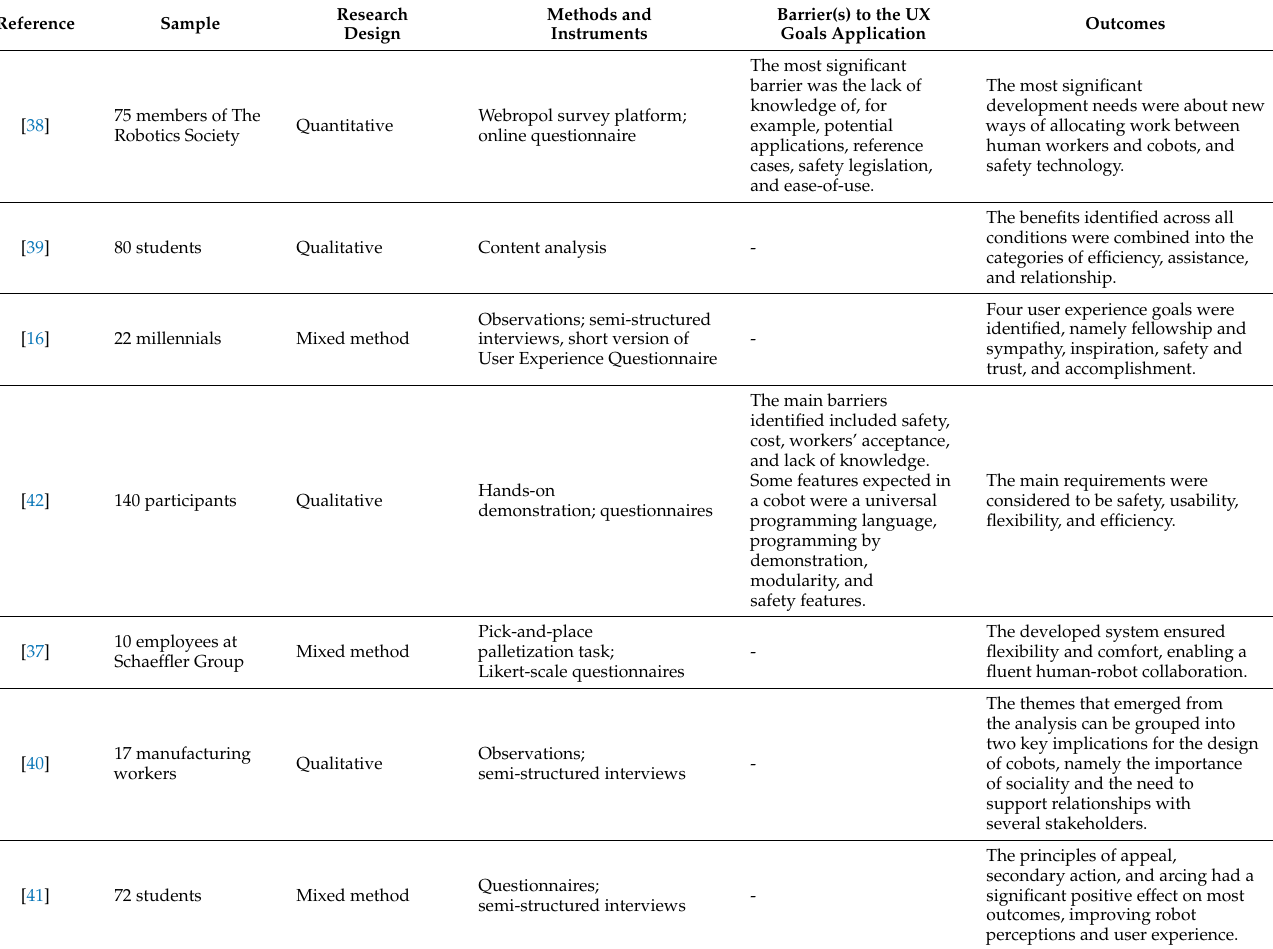
Table 2. Summary of the studies